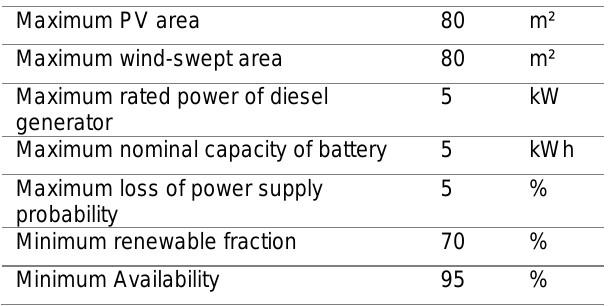
Table 7 . Constraints parameters